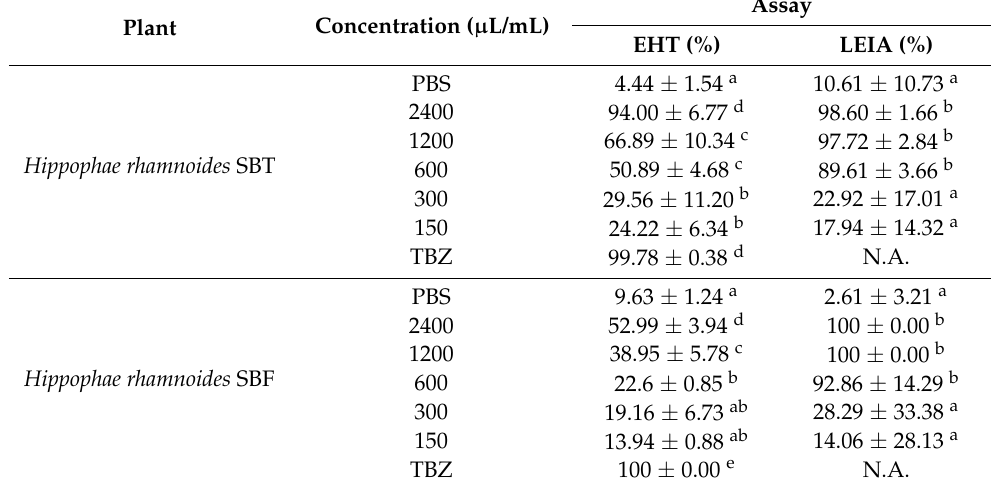
Table 3. Percentages of egg-hatch inhibition (EHT) and larval-exsheathment inhibition (LHT) shown by the two tested sea buckthorn juices at different concentrations ( ± standard deviations). No statistically significant differences were found between the values indicated with the same letter. SBT: sea buckthorn Tuscany, Italy; SBF: sea buckthorn Friuli-Venezia Giulia, Italy; PBS: phosphate-buffered saline; TBZ: thiabendazole; N.A.: not performed. Assay Plant Concentration ( µ L/mL) EHT (%) LEIA (%) PBS